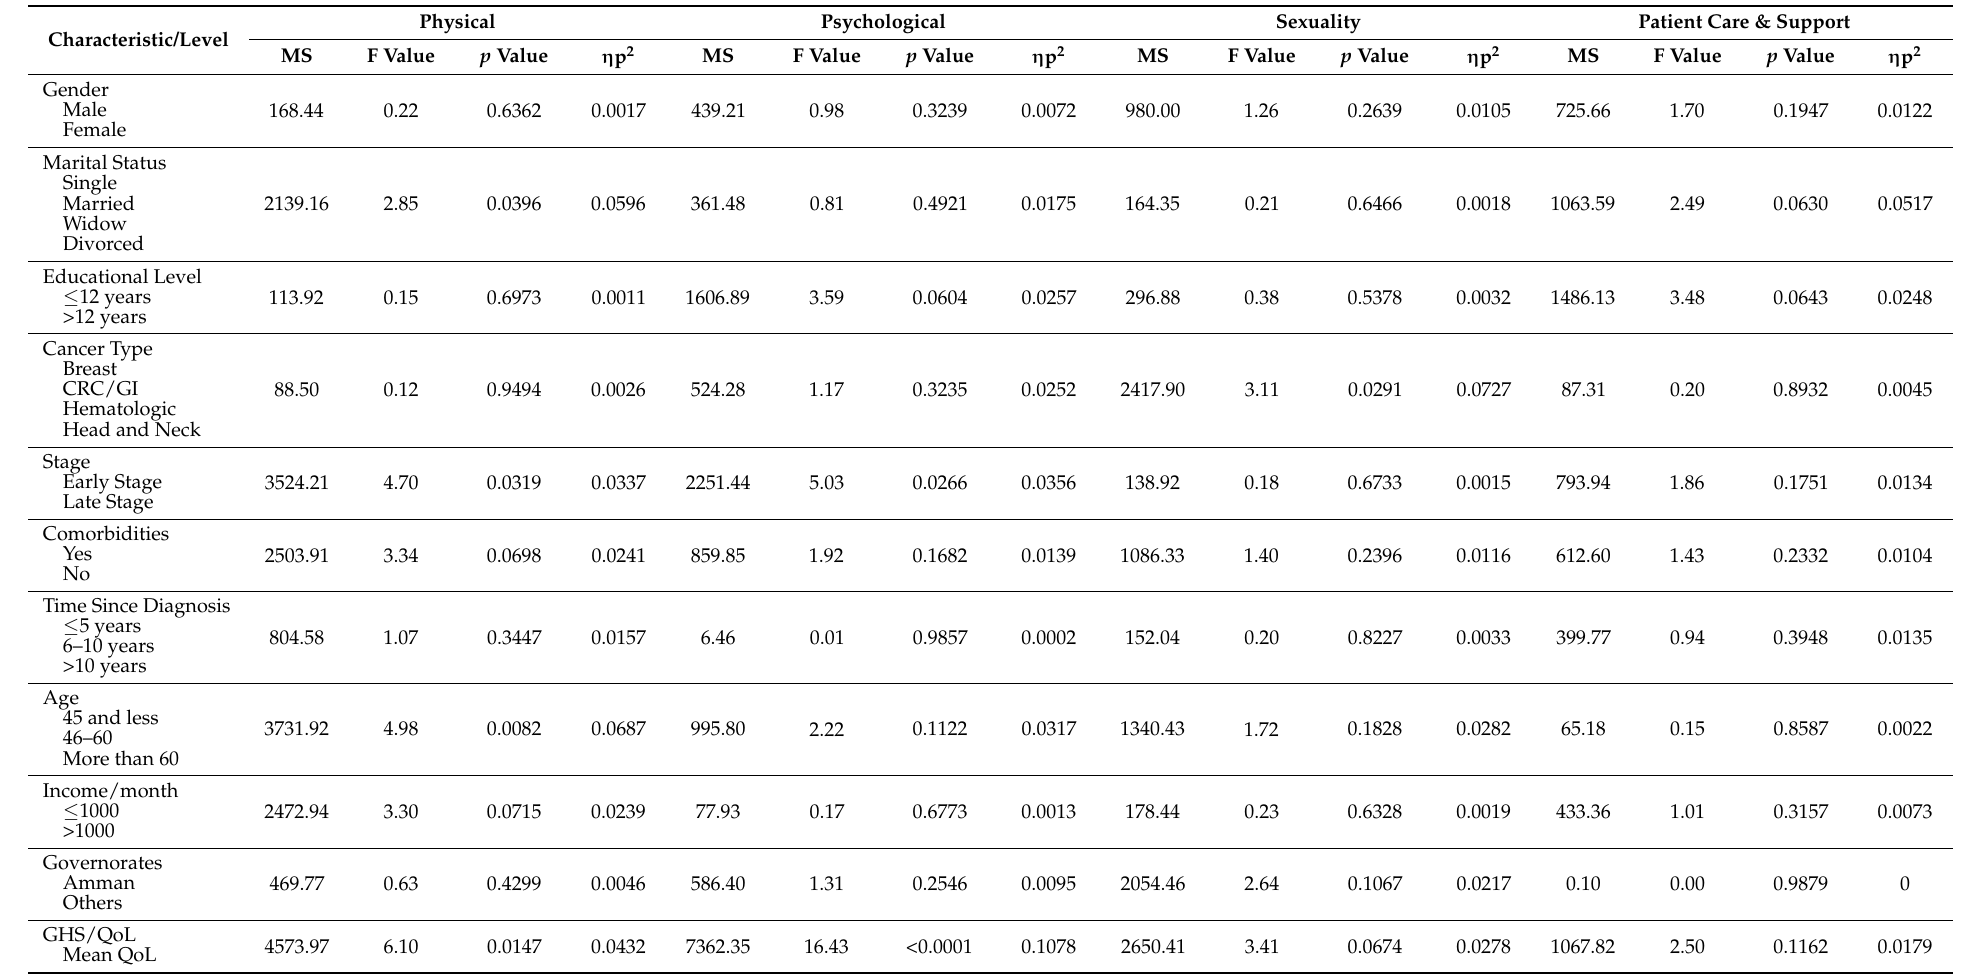
Table 5. Multivariate linear regression of mean scores of Physical, Psychological, Sexuality and Patient Care and Support domain-specific needs on the modified SCNS-SF (45